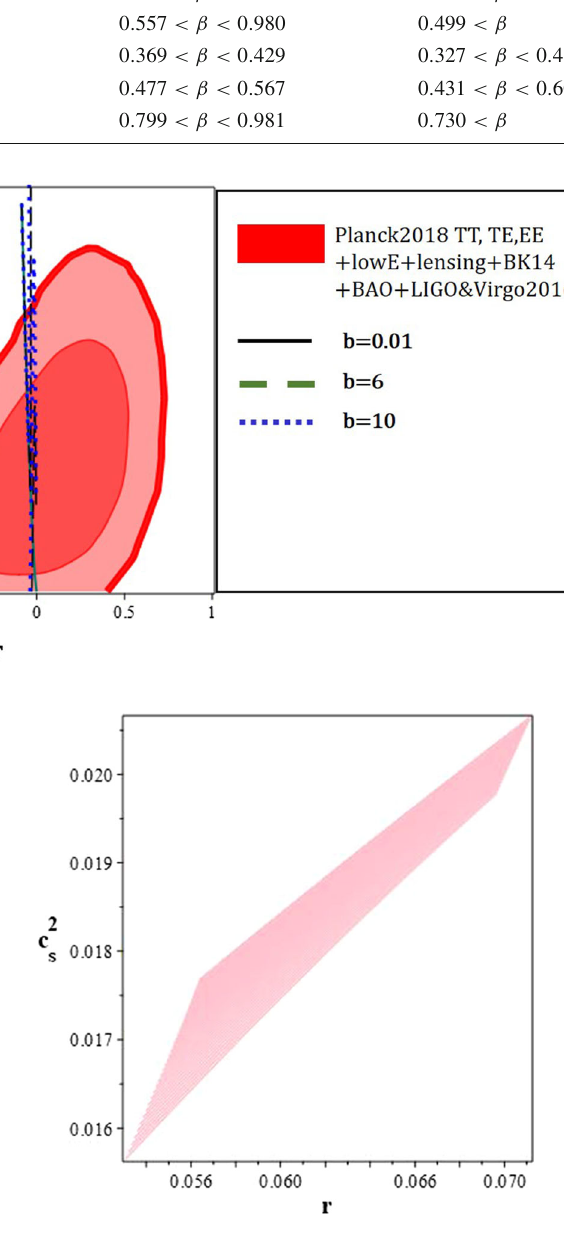
Fig. 8 The square of the sound speed versus the tensor-to-scalar ratio for the intermediate MDBI model. To plot this figure, we have adopted 0 . 340 < β < 0 . 4, 0 < b < 10 and N =